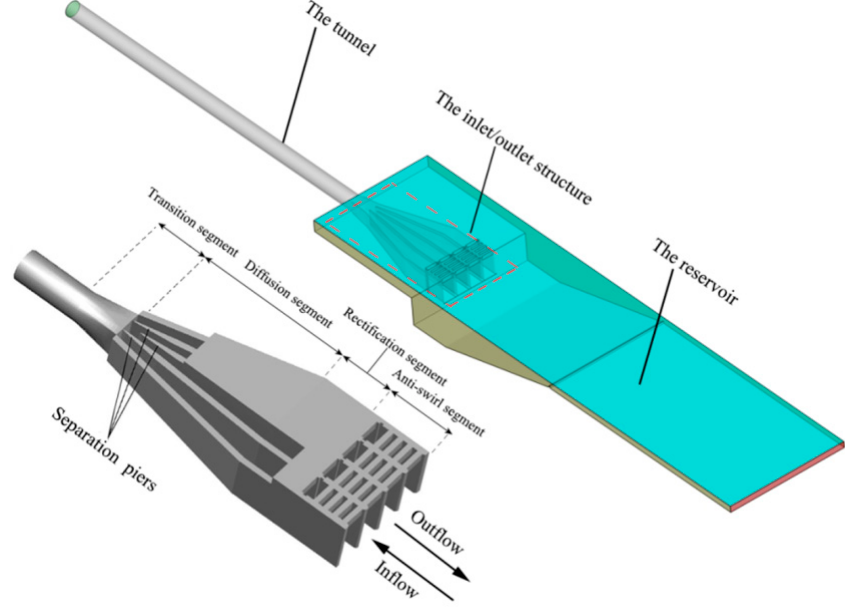
Figure 1. General structure of the lateral intake-outlet.